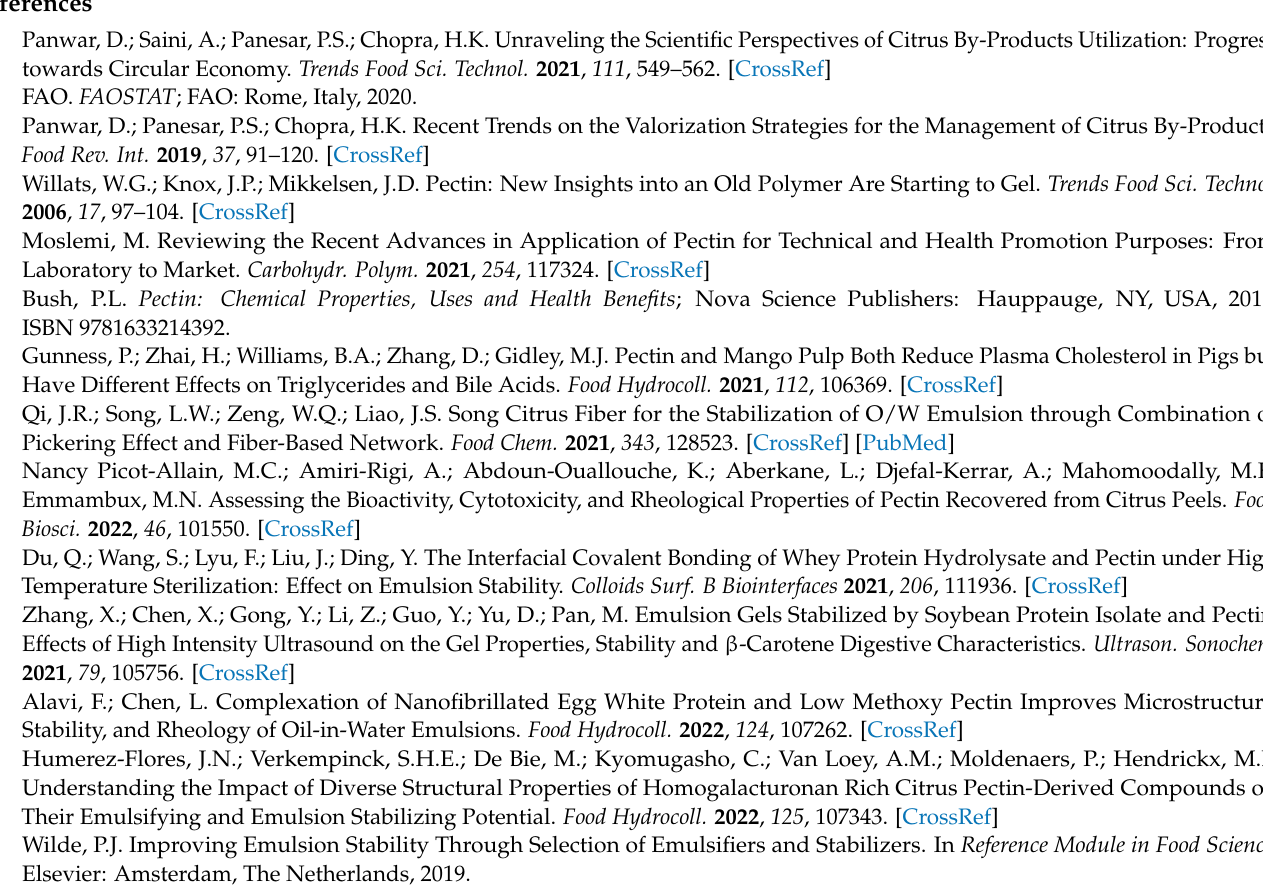
Figure S2: Calculated (calc) vs. experimental (average ± deviation) (exp) emulsions’ characteristics: percentiles of the droplet size distribution (d10, d50, and d90), flocculation, apparent viscosity, Z potential, and creaming index. Figure S3A: Histogram of residuals of the emulsions’ properties: percentiles of the droplet size distribution (d10, d50, and d90), flocculation, apparent viscosity, Z potential, and creaming index. Figure S3B: Residuals vs. calculated values of the emulsions’ properties: percentiles of the droplet size distribution (d10, d50, and d90), flocculation, apparent viscosity, Z potential, and creaming